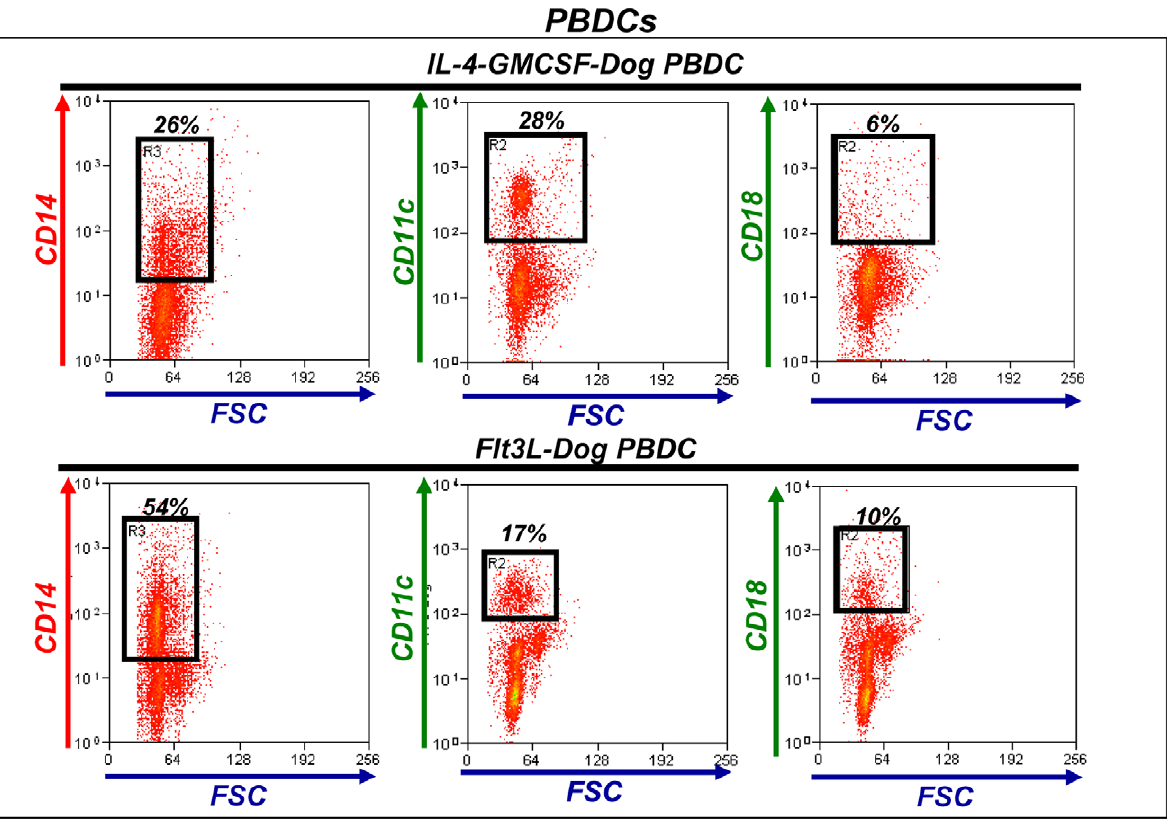
Figure 2. Phenotypic characterization of dog peripheral blood DC cultures. Peripheral blood cultures were collected after 7 days of culture with recombinant canine IL-4 and GM-CSF or Ad.hFlt3L conditioned medium. Immune cell populations in the culture were identified using antibodies against CD14 (monocytes), CD11c (dendritic cells) and CD18 (macrophages). Numbers in representative dot plots indicate the percentage of positive cells. Approximately 12,000 events were collected from each sample. Dot plots are representative of 4 dogs. SSC: Side Scatter; FSC: Forward Scatter.